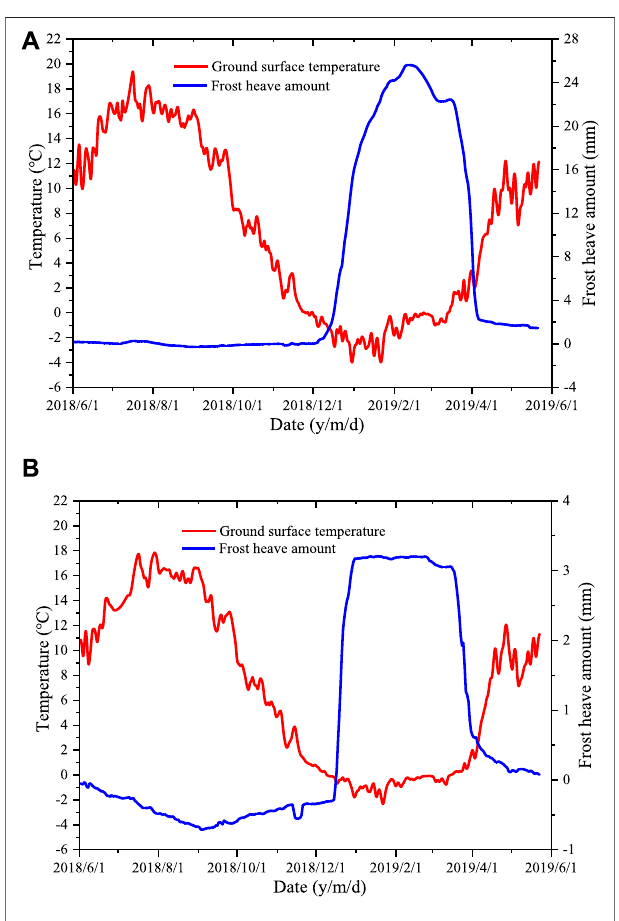
FIGURE 3 | Variations of the ground surface temperature and frost heave amount. (A) Data from the Qiujilangwa village monitoring site; (B) data from the Duoma village monitoring